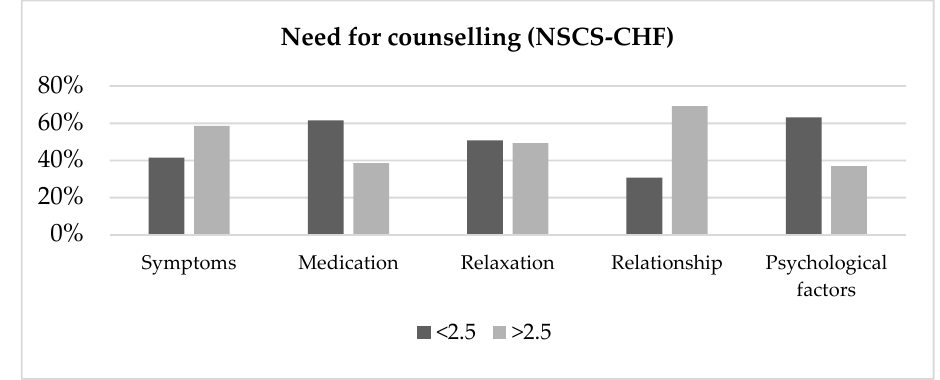
Figure 2. Experienced need for sexual counselling.